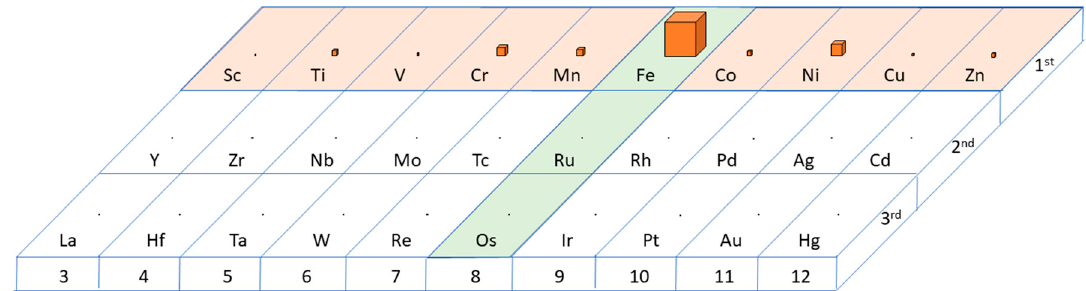
Figure 1. Relative atomic abundances of transition metal elements, highlighting the importance of the first row transition metal element iron (Fe), in terms of its combination of highest natural abundance of all transition metal atoms, as well as its belonging to the photochemically favorable group 8 together with rare ruthenium (Ru) and osmium (Os). Relative atomic abundances in the Earth’s crust according to data from Ref. [26] are proportional to the volumes of the cubes.